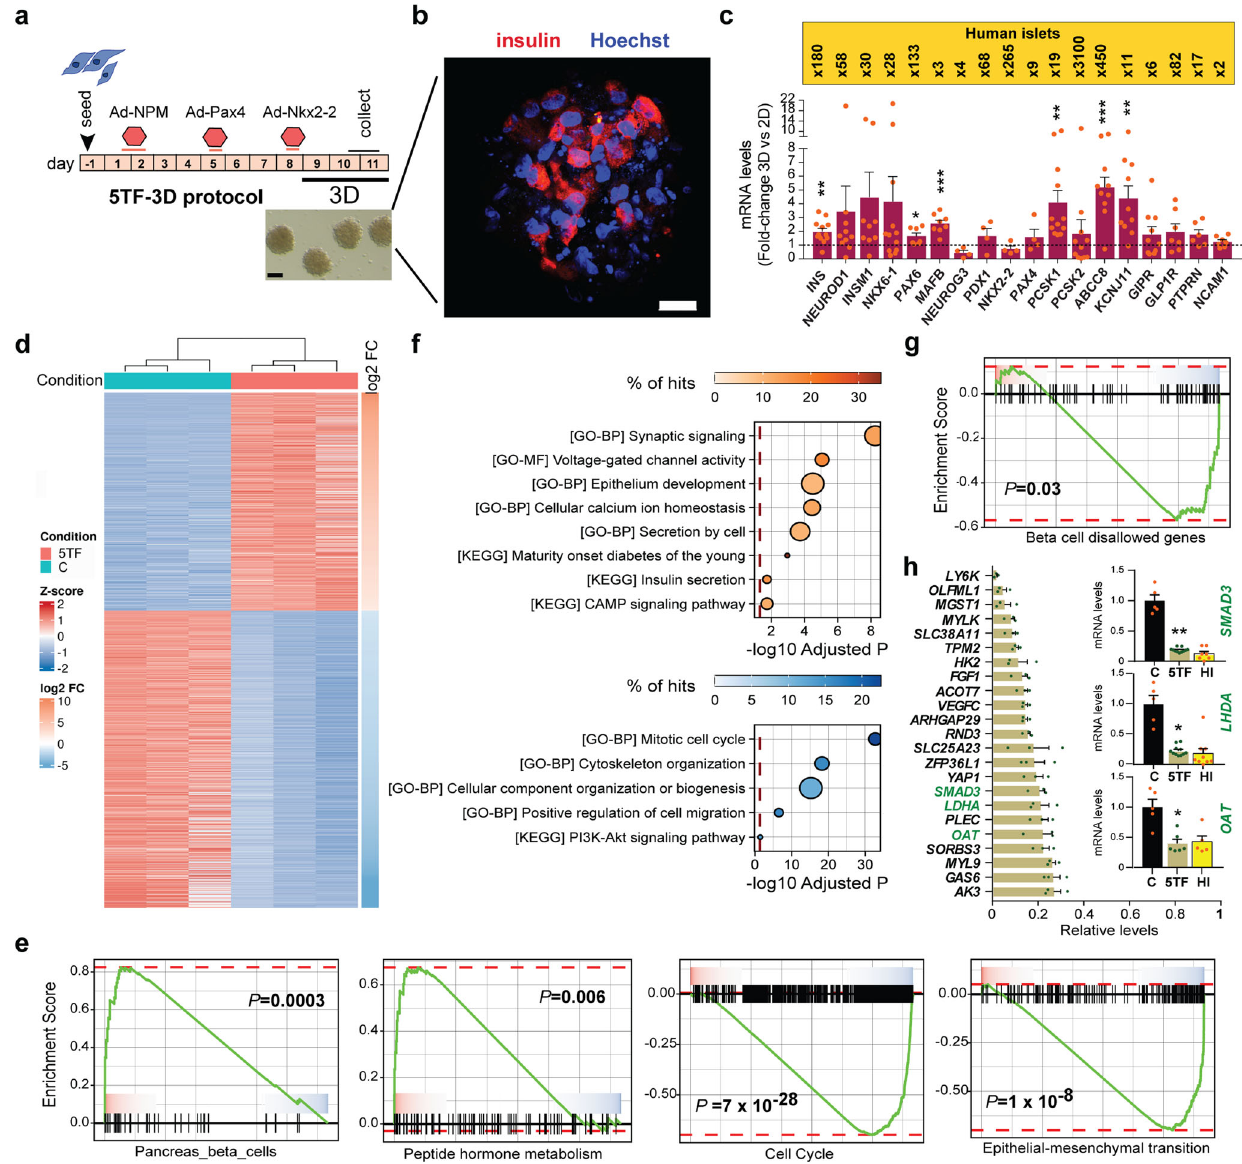
Fig. 5 Generation and transcriptomic characterization of 5TF cell spheroids. a Schematic representation of the modi fi ed 5TF protocol (5TF-3D): cells were moved from 2D to 3D culture during the last three days (days 7 – 10) of the protocol. Representative bright fi eld image of 5TF cell spheroids. Scale bar, 100 μ m. b Representative immuno fl uorescence image showing insulin staining in red and nuclei in blue (marked with Hoechst) of a 5TF cell spheroid at the end of the reprogramming protocol. Scale bar is 50 μ m. c qPCR of the indicated genes in 5TF cell spheroids. Transcript levels are expressed as fold relative to levels in 5TF cells maintained in 2D culture throughout the 10-day protocol (given the value of 1, dotted line). Data are mean ± SEM for n = 4 – 12. * P < 0.05, ** P < 0.01, *** P < 0.001 relative to 2D culture using one-sample t -test. Fold-change differences in expression levels between human islets and 3D-5TF reprogrammed cells are shown in the upper yellow box. d Heat map of differentially expressed genes between parental fi broblasts (C) and 5TF cell spheroids ( n = 3 reprogramming experiments). e GSEA plots on indicated gene sets and pathways. f Dot plots showing the enrichment analysis on Gene Ontology (GO) and KEGG categories of differentially expressed genes (gained in red, lost in blue) between fi broblasts (C) and 5TF cells. The X -axis represents the adjusted p value, the size of the dot represents the number of enriched genes (count) and the color intensity of the dots represents the percentage of hits in each category. g GSEA plot on β -cell disallowed genes. h Relative expression levels of β -cell disallowed genes repressed in 5TF cell spheroids as compared to fi broblasts (given the value of 1) based on RNA-seq data normalized expression values. Data are mean ± SEM ( n = 3). Insets show mRNA expression of the indicated genes in untreated control fi broblasts ( n = 5), 5TF cell spheroids ( n = 6) and human islets ( n = 5) as assessed by qPCR. Expression levels were calculated relative to TBP . Data are mean ± SEM. * P < 0.05, ** P < 0.01 relative to control fi broblasts using unpaired t somatostatin staining was undetectable (Fig. 5b and Supple- subunits KCNJ11 and ABCC8 , showed a higher response (4 to 5- mentary Fig. 3). While INS transcript levels were nearly 2-fold fold) to 3D culture (Fig. 5c). Thus, cell aggregation during the last higher in 5TF cell spheroids compared to 5TF cells kept in stage of reprogramming (note that total length of the protocol monolayer, other β -cell marker genes, such as the prohormone was not changed) conferred improved activation of genes asso- convertase PCSK1 and the ATP-sensitive potassium channel ciated to β -cell function. Despite increased gene activation, β -cell